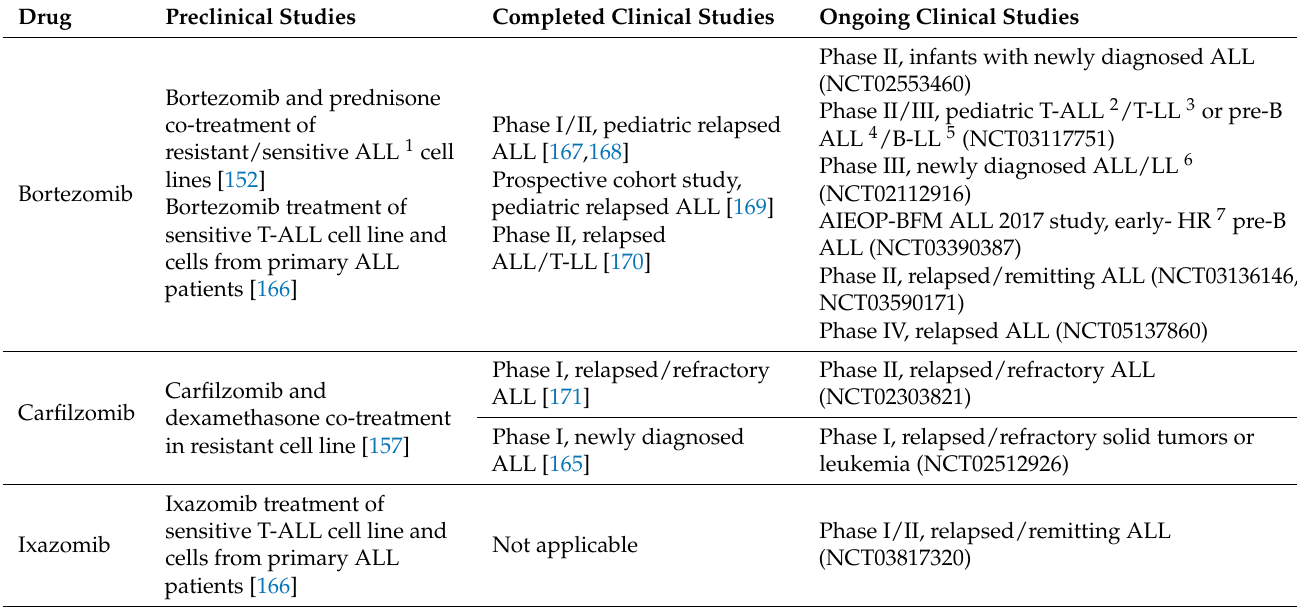
Table 3. Proteasome inhibitors in ALL